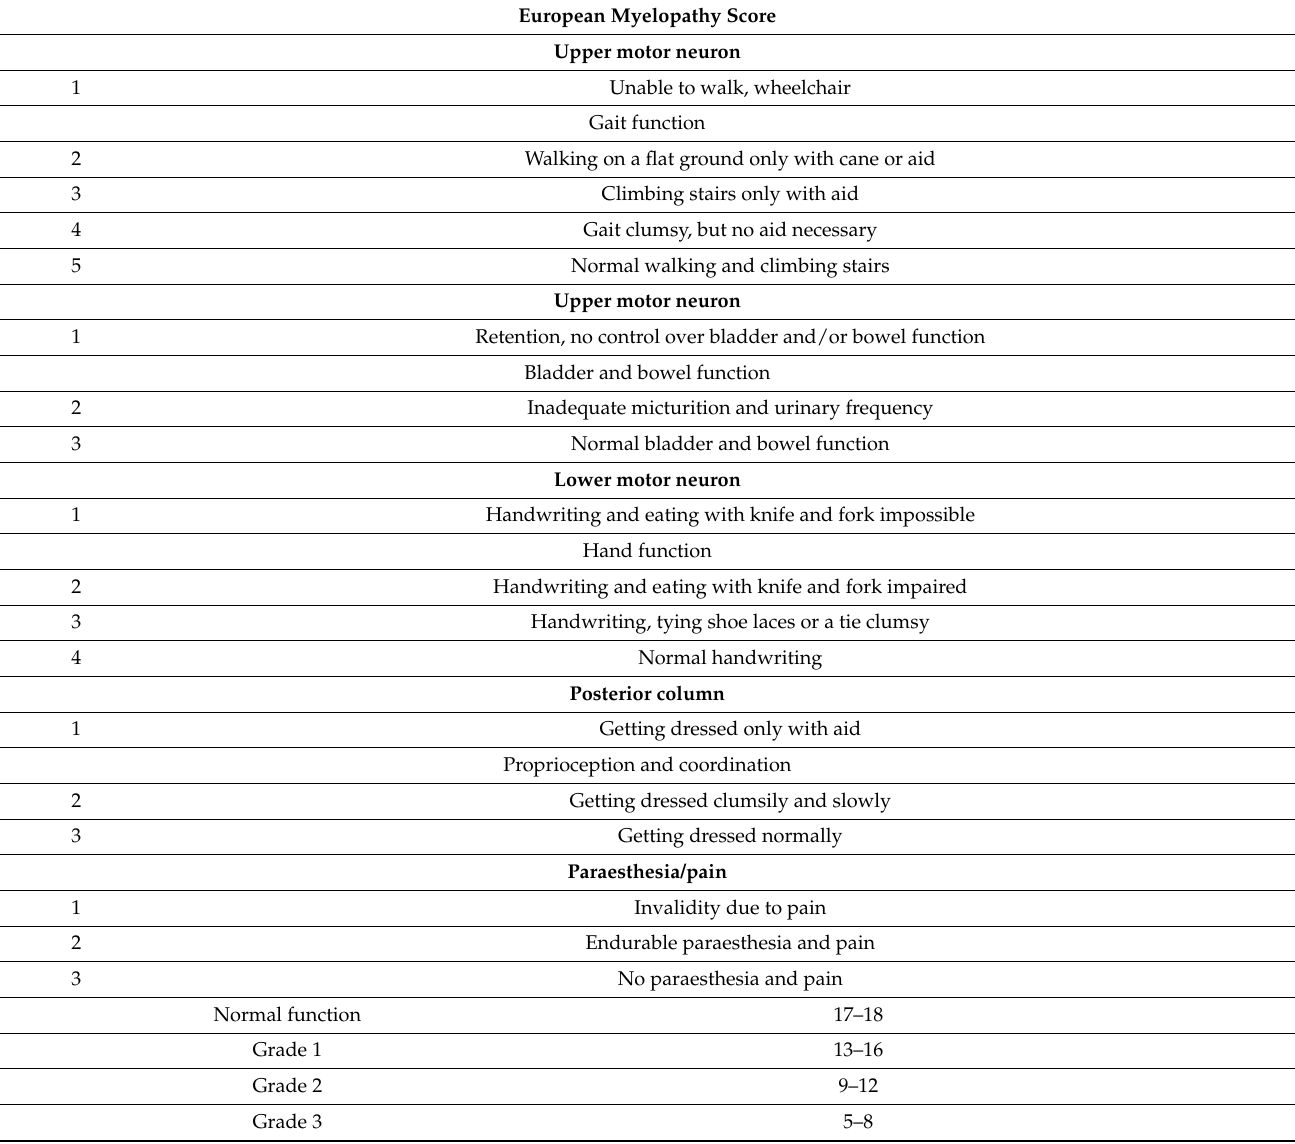
Table A6. European Myelopathy Score [49].